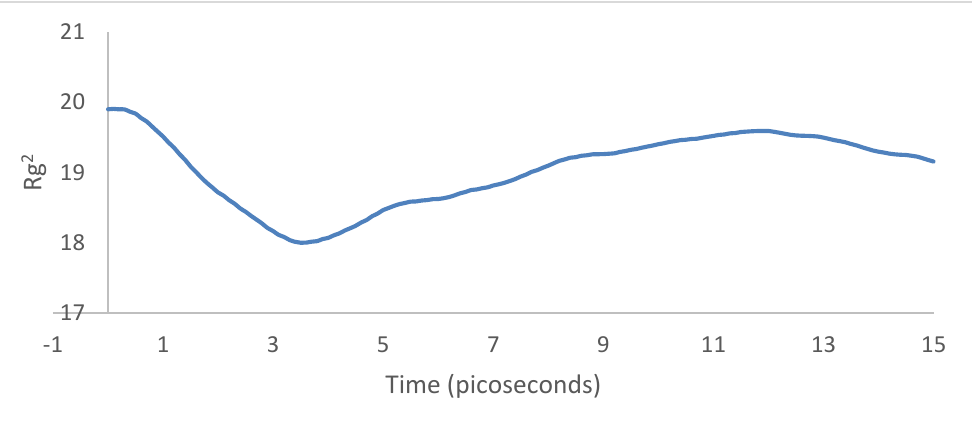
Figure 26. Radius of gyration: 4PPV–7 nm × 7 nm graphene).